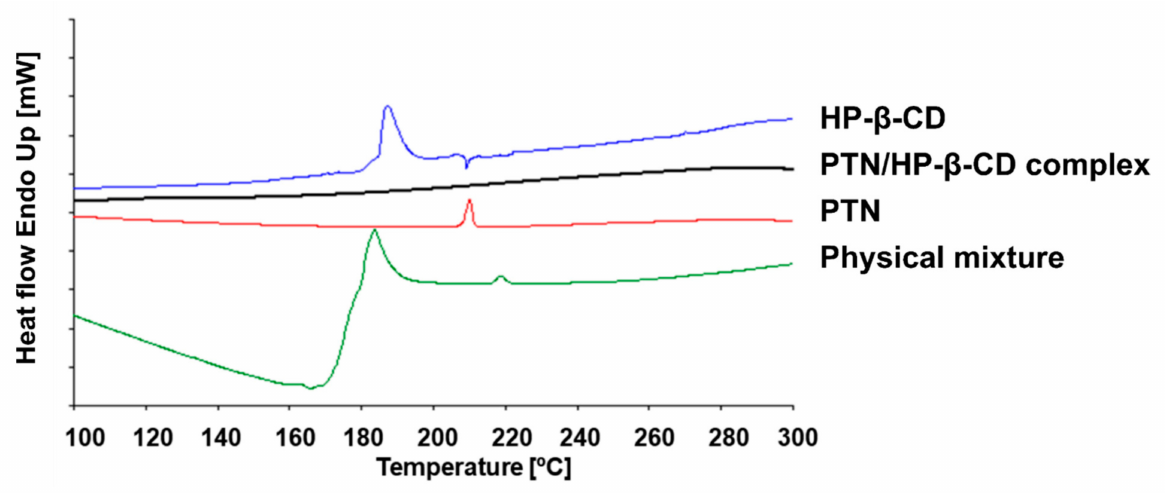
Figure 7. DSC curves of HP- β -CD, PTN, physical mixture (1:1 molar ratio of PTN and HP- β -CD), and PTN/HP- β -CD complexes. The heating rate was 10 ◦ C min − 1 . The thermograms were adjusted for better